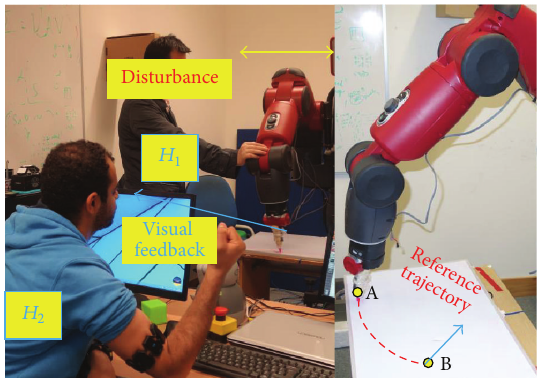
Figure 11: Robot arm antidisturbance test II: Baxter Robot 𝑆 0 joint will follow a reference trajectory while a random disturbance imposes on Baxter Robot arm, and the human subject 𝐻 2 would strengthen his arm to reduce the external disturbance with the same stiffness transfer interface as antidisturbance test